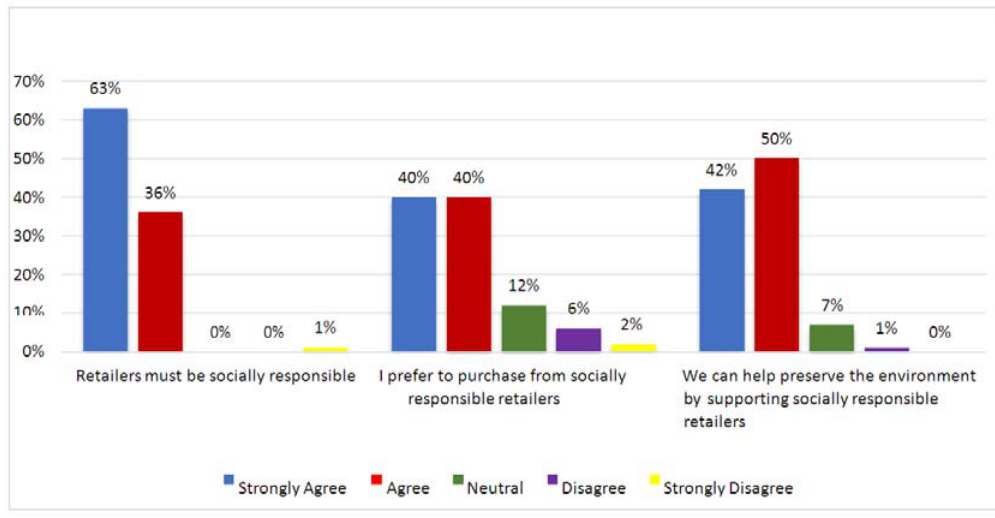
Fig. 4. Respondent attitude toward green